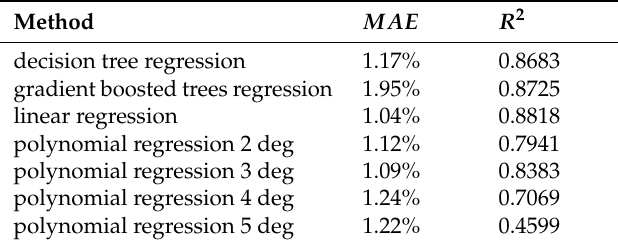
Table 2. Accuracy of regression methods.